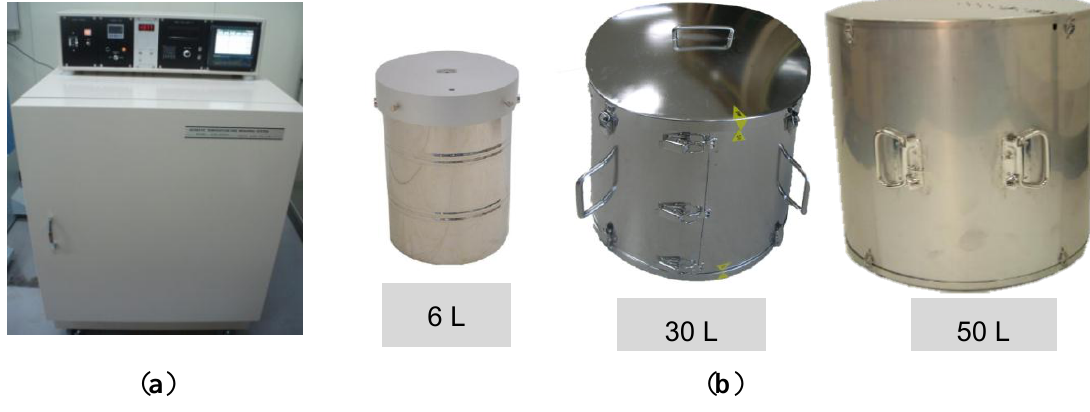
Figure 2. Adiabatic temperature rise apparatus. ( a ) Main body; ( b ) specimen